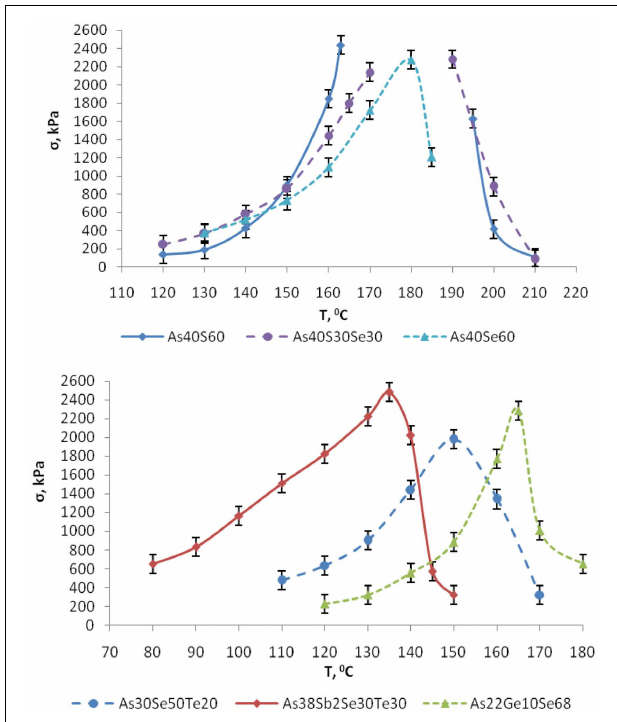
FIGURE 9 |Temperature dependence of the separation tension ( σ ) of chalcogenide glasses from silica glass (Shiryaev et al., 2015) .